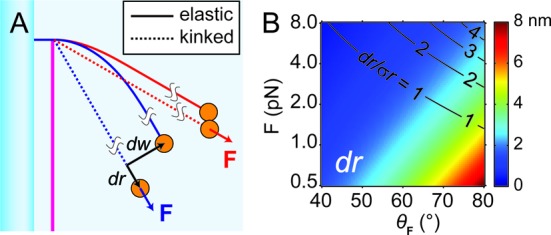
Comparison between kinking and elastica model of DNA bending. (A) Cartoon of the DNA pulley comparing the two conformations: elastic bending (solid curve) and kinking (dotted line). The blue and red sets of lines show that the impact of kinking on bead displacements, dr and dw, depends on the direction of the applied force vector, F. (B) Calculation of dr for experimentally feasible range of F. |F| is the magnitude of the force, and \documentclass[12pt]{minimal}
\usepackage{amsmath}
\usepackage{wasysym} 
\usepackage{amsfonts} 
\usepackage{amssymb} 
\usepackage{amsbsy}
\usepackage{upgreek}
\usepackage{mathrsfs}
\setlength{\oddsidemargin}{-69pt}
\begin{document}
}{}$\theta _{\bf F}$\end{document} is the angle between F and x-axis. The ability to resolve length changes dr depends on the ratio of dr to the amplitude of the thermal fluctuations along \documentclass[12pt]{minimal}
\usepackage{amsmath}
\usepackage{wasysym} 
\usepackage{amsfonts} 
\usepackage{amssymb} 
\usepackage{amsbsy}
\usepackage{upgreek}
\usepackage{mathrsfs}
\setlength{\oddsidemargin}{-69pt}
\begin{document}
}{}$\hat r$\end{document}, σr. Black contours indicate lines of constant dr/σr.